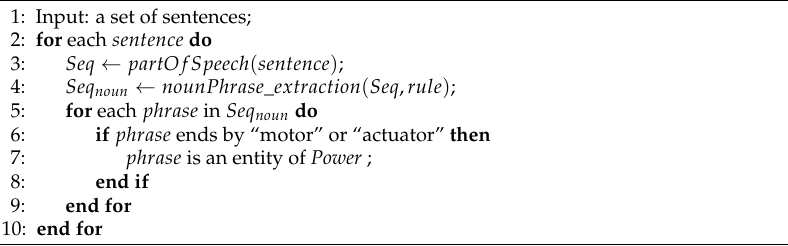
Figure 5. Extract entities belonging to Power